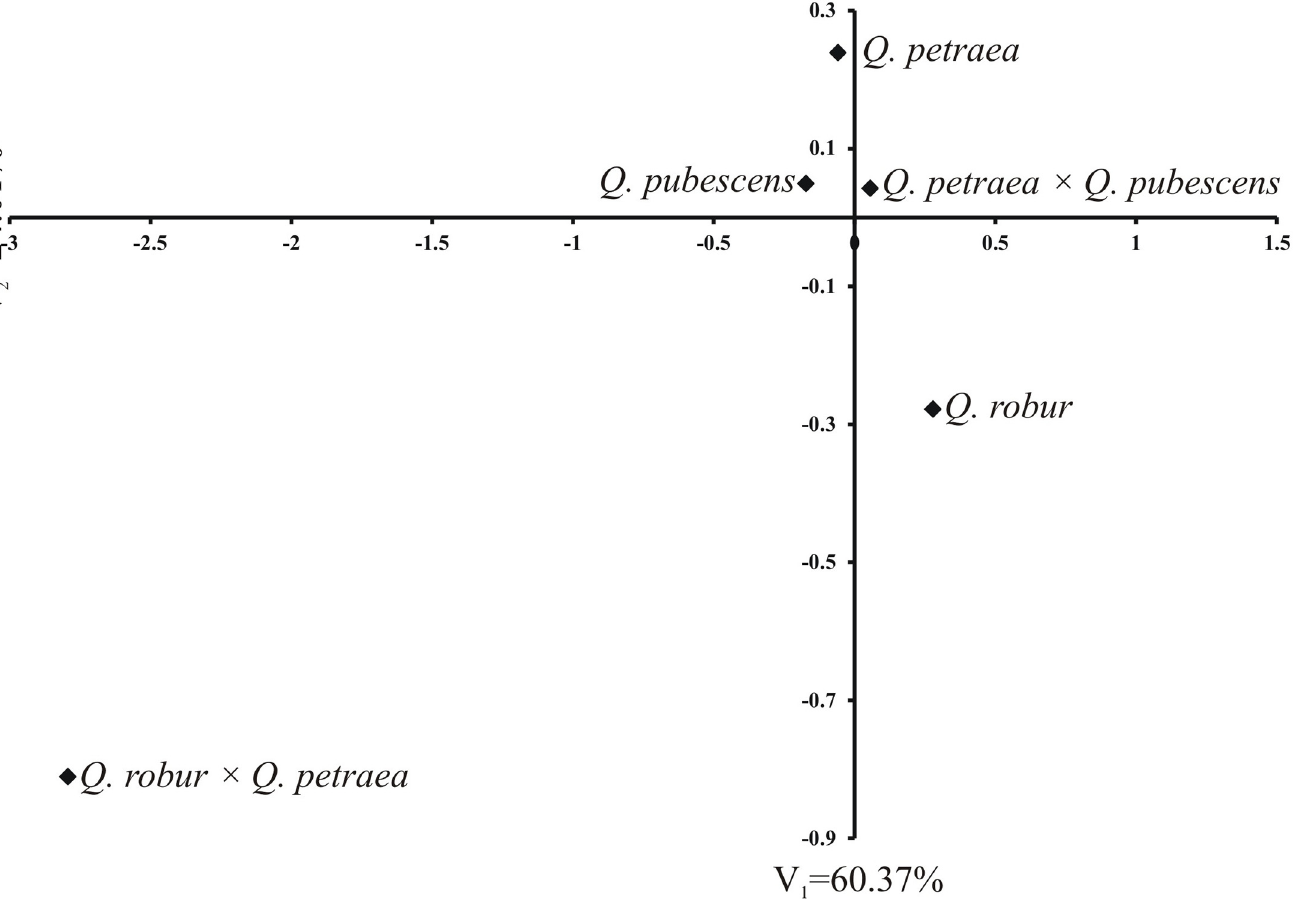
Fig 5. Distribution of five Quercus taxa studied in the space of two first canonical